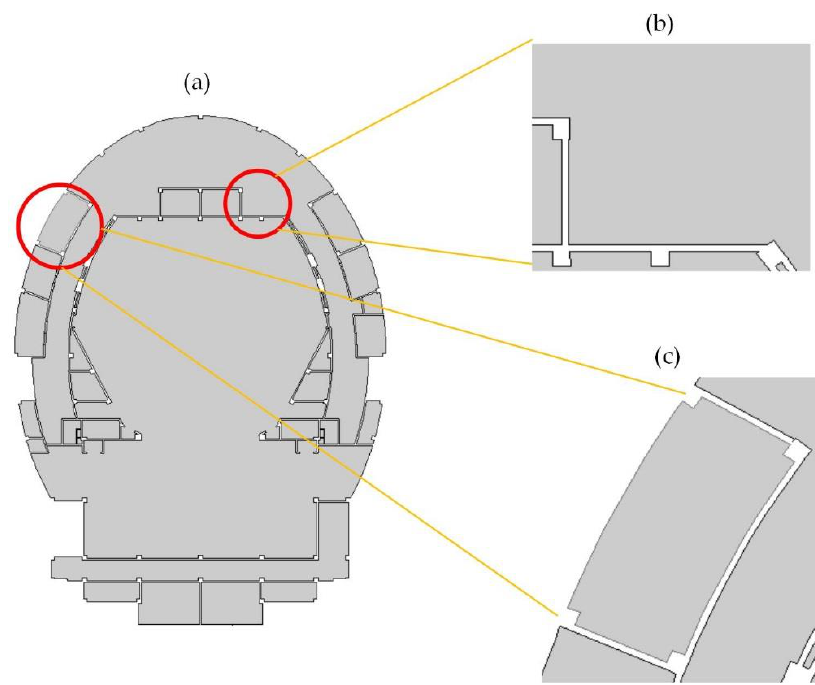
Figure 22. Extraction results obtained using the search-loop method: ( a ) first floor plan, ( b ) isolated column, and ( c ) isolated wall. ISPRS Int. J. Geo-Inf. 2018 , 7 , x FOR PEER REVIEW